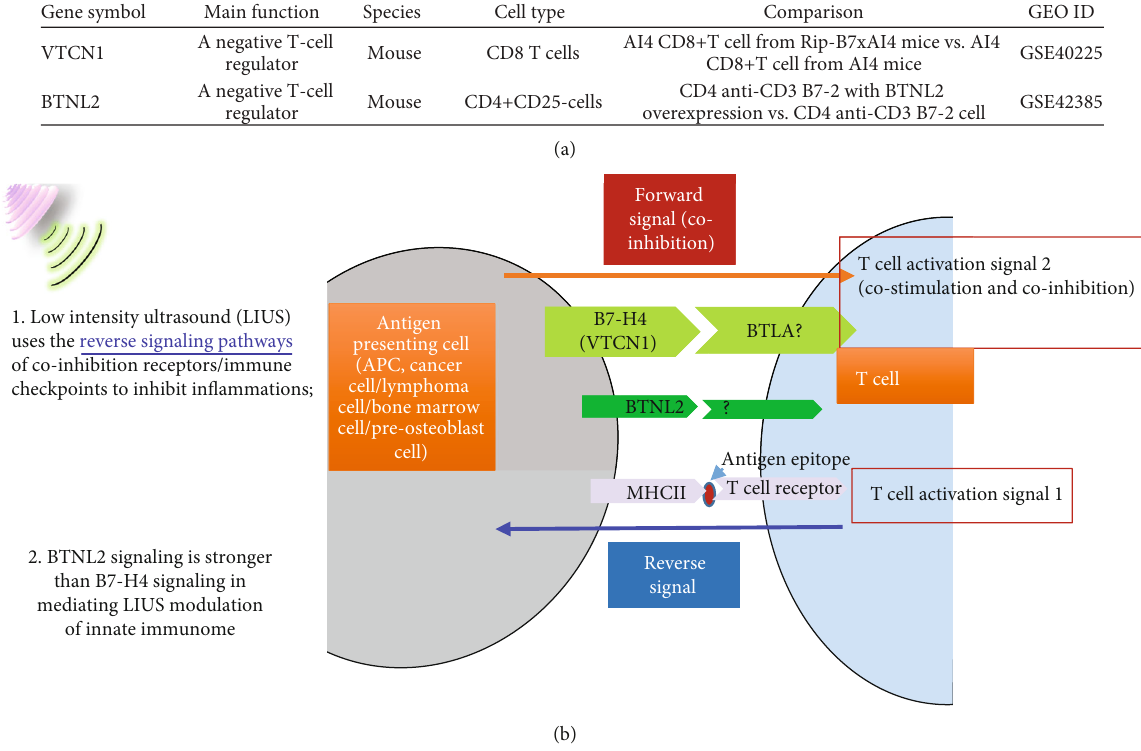
Figure 8: (a) The microarrays oftwo coinhibition/immune checkpoint receptors B7-H4 (VTCN1) and BTNL2 were used in this study to determine whether LIUS modulation ofinnatomic genes uses the reverse signaling pathways ofthe T cell coinhibition receptors (see our recent report, PMID: 30468648). Figure 8: (b) Overexpression of coinhibition receptor VTCN1 (B7-H4) promotes more LIUS upregulation of innatomic genes (8 genes, 10.4%) than downregulation ofthese genes in lymphoma cells (2 genes, 5.1%). However, VTCN1 promotes more LIUS downregulation ofinnatomic genes (27, 14.8%) than upregulation ofthese genes in bone marrow cells (10 genes, 9.3%) (see supplemental Table 15 for details). Figure 8: (c) Overexpression of coinhibition receptor butyrophilin-like 2 (BTNL2) promotes more LIUS-upregulation of innatomic genes than downregulation of these genes. The results show that in lymphoma cells, overexpression of BTNL2 downregulates (20.8%) more than it upregulates (16.9%) 77 LIUS-upregulated genes. In addition, BTNL2 upregulates (28.2%) more than it downregulates (23.1%) 39 LIUS-downregulated genes. These results suggest that BTNL2 overexpression inhibits more LIUS-upregulated genes and promotes more LIUS-downregulated genes. In addition, the results show that in preosteoblast cells, overexpression of BTNL2 downregulates (42.9%) more than it upregulates (28.6%) 21 LIUS-upregulated genes. In addition, BTNL2 upregulates (23.5%) more than it downregulates (17.6%) 17 LIUS-downregulated genes. These results suggest that BTNL2 overexpression inhibits more LIUS-upregulated genes and promotes more LIUS-downregulated genes. Moreover, the results show that in bone marrow cells, overexpression of BTNL2 downregulates (32.4%) more than it upregulates (23.1%) 108 LIUS-upregulated genes. In addition, BTNL2 upregulates (29.1%) as much as it downregulates (29.1%) 182 LIUS-downregulated genes. These results suggest that BTNL2 overexpression inhibits more LIUS-upregulated genes and up-, downregulates the same numbers (29.1%) of LIUS-downregulated genes (see supplemental Table 16A for details). In addition, the results show that in preosteoblast cells, overexpression of BTNL2 downregulates (42.9%) more than it upregulates genes. These results suggest that BTNL2 overexpression inhibits more LIUS-upregulated genes and promotes more LIUS-downregulated genes. Moreover, the results show that in bone marrow cells, overexpression of BTNL2 downregulates (32.4%) more than it upregulates (23.1%) 108 LIUS-upregulated genes. In addition, BTNL2 upregulates (29.1%), as much as it downregulates (29.1%) 182 LIUS-downregulated genes. These results suggest that BTNL2 overexpression inhibits more LIUS-upregulated genes and up-, downregulates the same numbers (29.1%) of LIUS- downregulated genes (see supplemental Tables 16B and 16C for details). Figure 8: (d) LIUS modulation of innatomic genes use the forward/reverse signaling pathways ofthe T cell coinhibition receptors/immune checkpoints (see our recent report, PMID: 30468648). B7-H4 receptor was proposed to be BTLA, which has not been confirmed (PMID: 28325750). BTNL2 is considered to be a member ofthe B7 family of costimulatory receptors, which include CD80 (B7.1), CD86 (B7.2), CD274 (B7-H1, PD-L1), CD275 (ICOS-L), CD276 (B7-H3), CD277(BTN3A1), mouse Skint1 and Btnl2, and myelin oligodendrocyte glycoprotein(PMID: